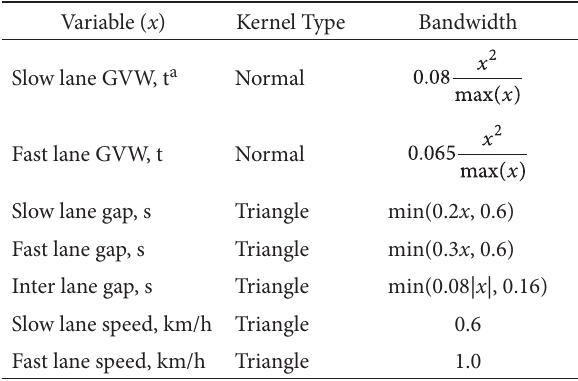
Fig. 2. Sample scenario showing the properties which are varied in Scenario Modelling (GVW = gross vehicle weight) Table 1. Bandwidths used for kernel